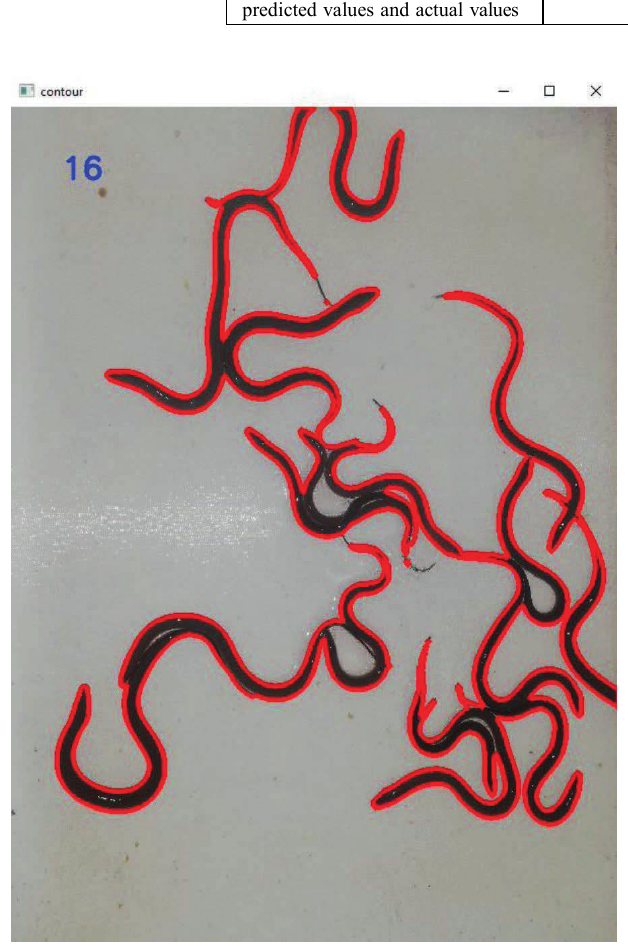
Fig. 9. An illustration of counting and filtering eels based on the size. The blue number “16” reveals the number of eels predicted in the image.